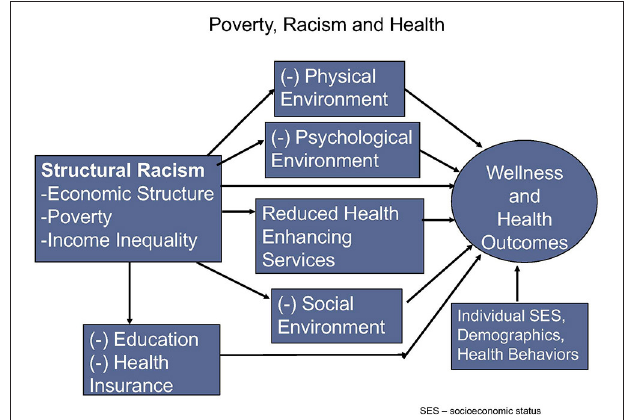
FIGURE 1 | A conceptual framework emphasizing the key pathways through which poverty and structural racism may influence wellness and health outcomes [adapted from Wen et al.